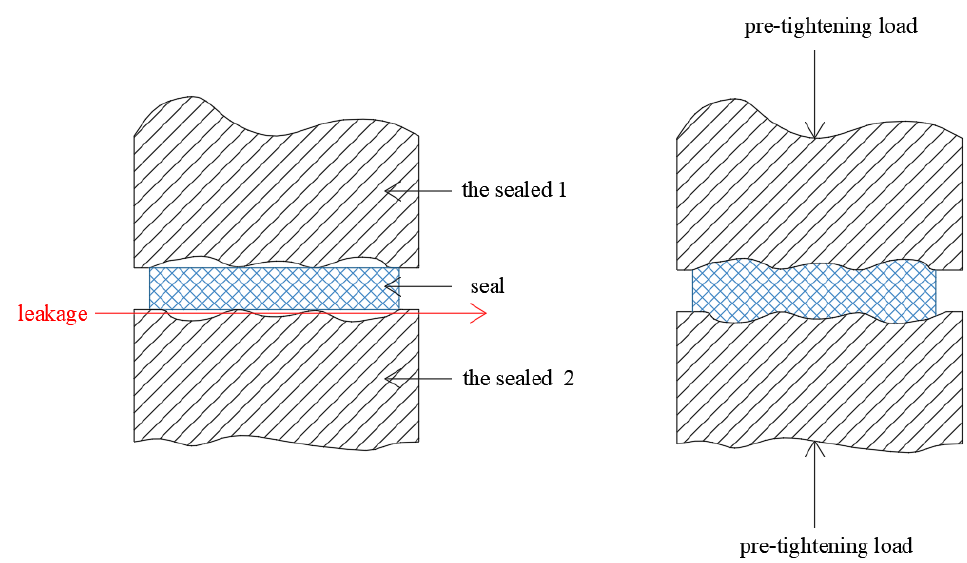
Figure 2. Schematics of the principle of pre-compressing static sealing.